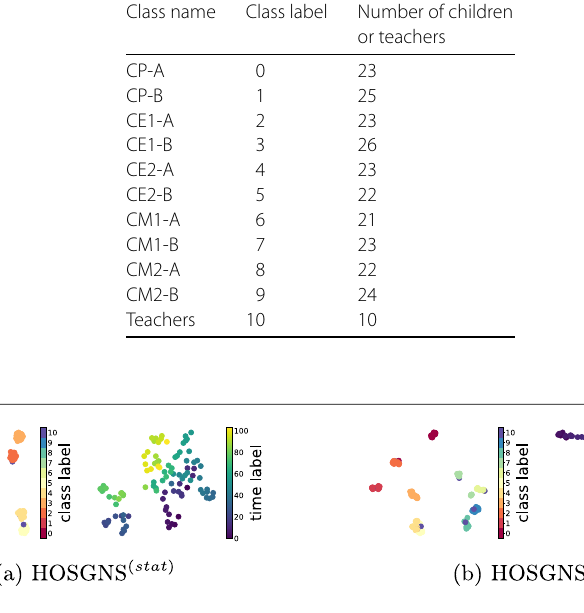
Figure 3 Two-dimensional projections of the 128-dim embedding manifold spanned by embedding matrices W (left of each panel) and T (right of each panel), trained on L YON S CHOOL data, of HOSGNS model trained on: ( a ) P (stat) and ( b ) P (dyn) . These plots show how the community structure and the evolution of time is captured by individual node embeddings { w i } i ∈ V and time embeddings { t k } k ∈